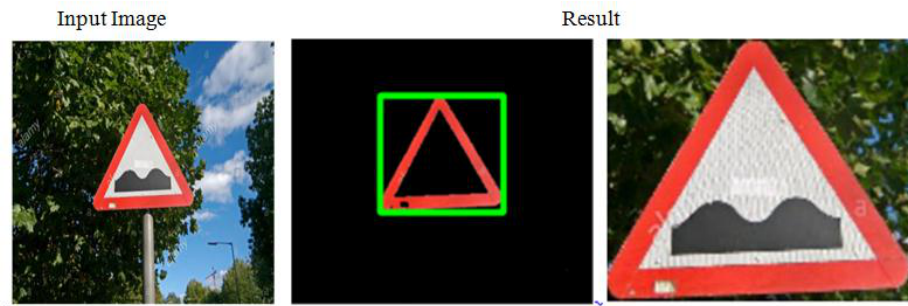
Fig. 15. ROI created and detecting red colour object.